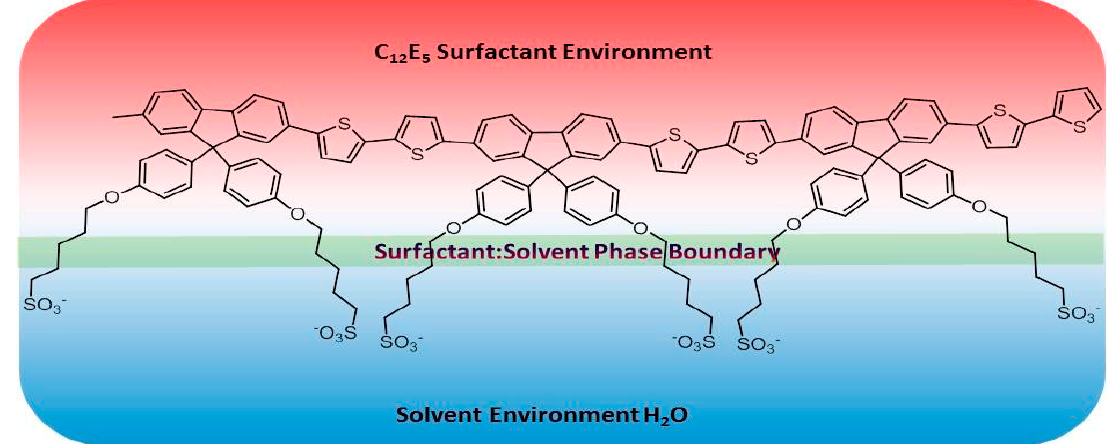
Figure 6. A schematic representation of the specific interactions occurring within the PBS-PF2T assemblies. The backbone interacts predominantly with the surfactant whereas the side chains interact more strongly with the surrounding solvent.